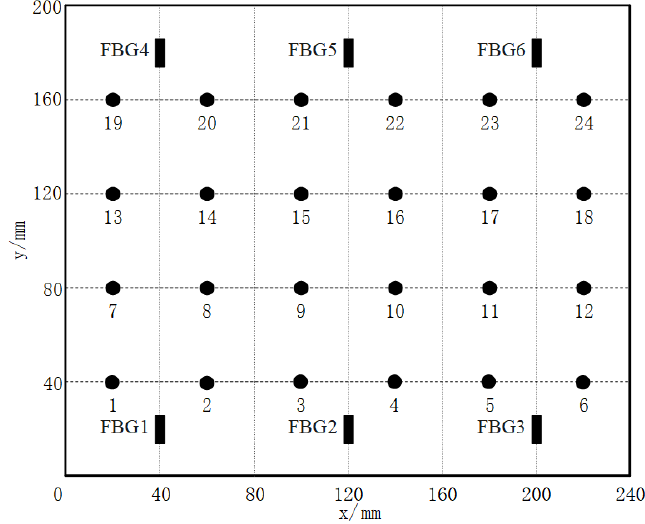
Figure 6. The sensor arrangement and impact